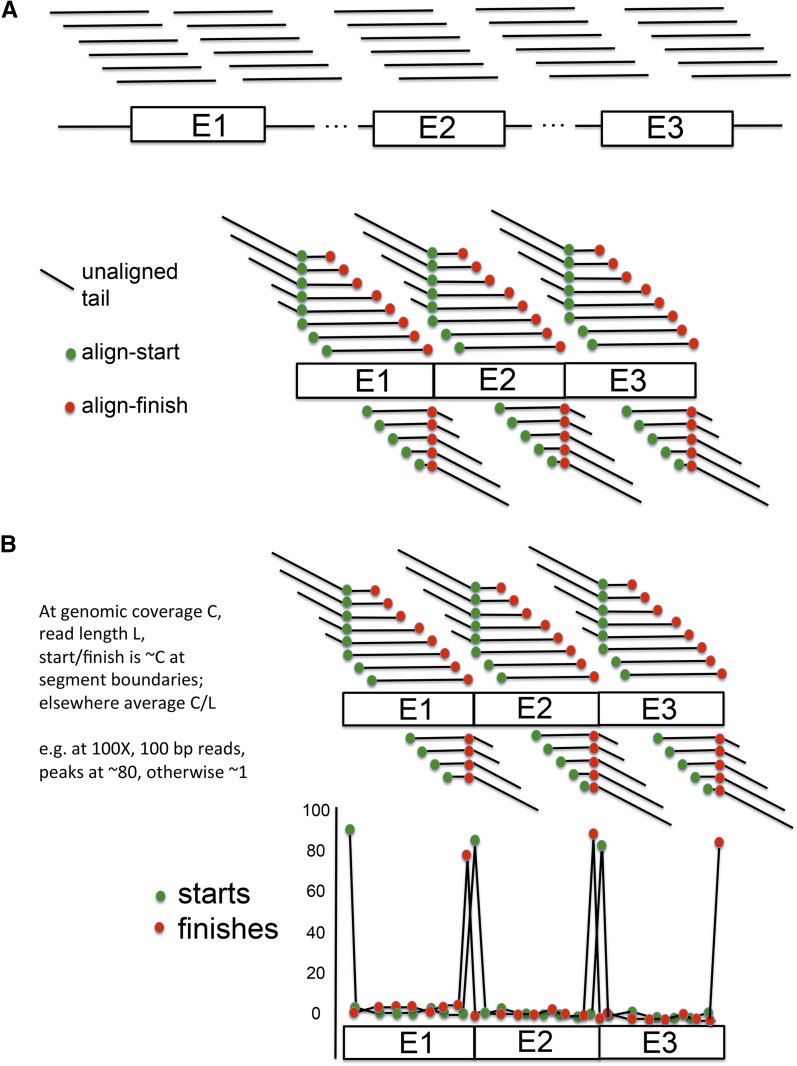
Local alignment of genomic reads to transcripts gives a signature for junctions of discontiguous genomic encoding segments. (A) Tiled Illumina reads derived from the genome covering discontiguous segments E1, E2, and E3 (top) are aligned locally (not requiring alignment across the complete read) to the fused structure E1–E2–E3 (bottom). These reads have starting and finishing positions of alignment to the E1–E2–E3 structure (green and red dots). (B) The result for random starts and finishes of reads in the genome is a huge enrichment of start positions at the beginnings of the genomically discontiguous segments E1, E2, and E3, and for alignment finishes at the ends of E1, E2, and E3 (top). This enrichment is on average the read-length (e.g., 100 × for 100-bp reads). The plot of starts and finishes of alignments by position then yields a highly sensitive indicator of the segment boundaries.